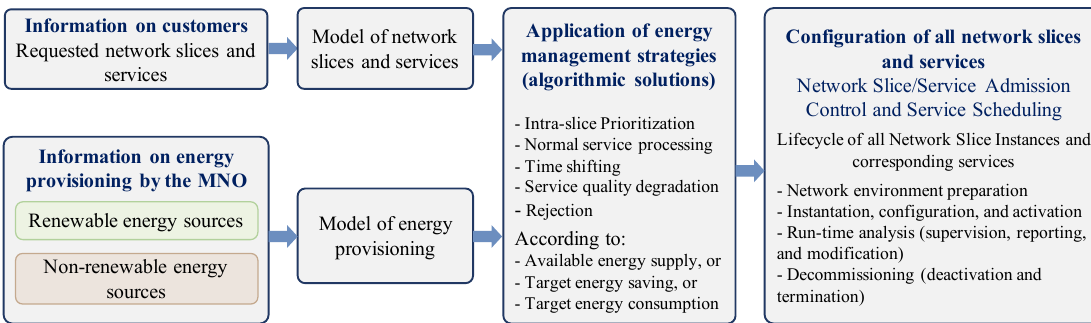
Figure 3. Description of the energy-aware network slice creation in the adaptive energy management architecture. The network slices and corresponding services are configured to achieve energy efficiency, considering a finite energy provisioning and the optimization of power consumption, specifically through the minimization of the consumption of non-renewable energy